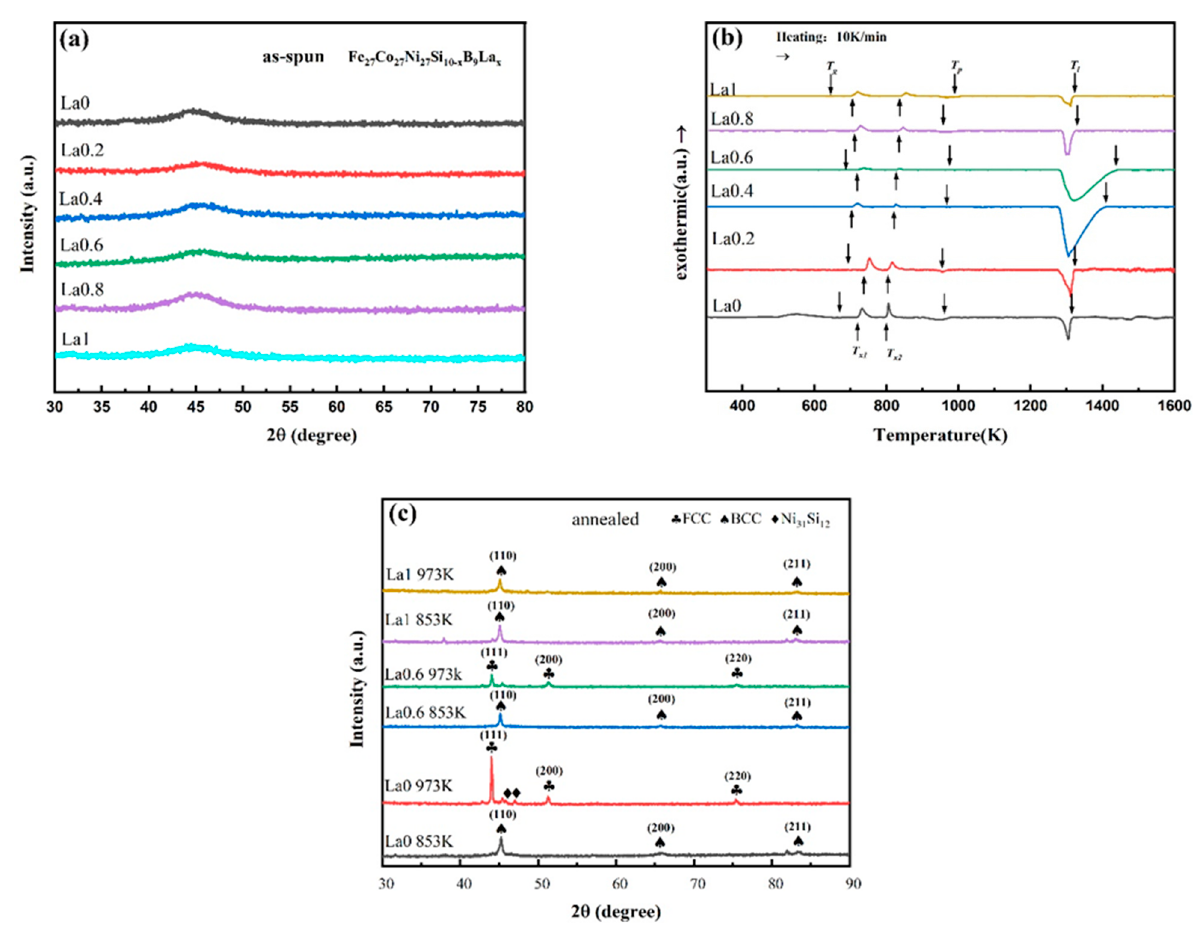
Figure 2. ( a ) XRD patterns of as-spun Fe 27 Co 27 Ni 27 Si 10 − x B 9 La x (x = 0 to 1) alloys, ( b ) DSC curve of as-spun Fe 27 Co 27 Ni 27 Si 10 − x B 9 La x alloys, and ( c ) XRD patterns of amorphous ribbons annealed for 5 min at 853 and 973 K. Table 2. Thermal parameters of Fe 27 Co 27 Ni 27 Si 10 − x B 9 La x amorphous ribbons. Composition (at.%)